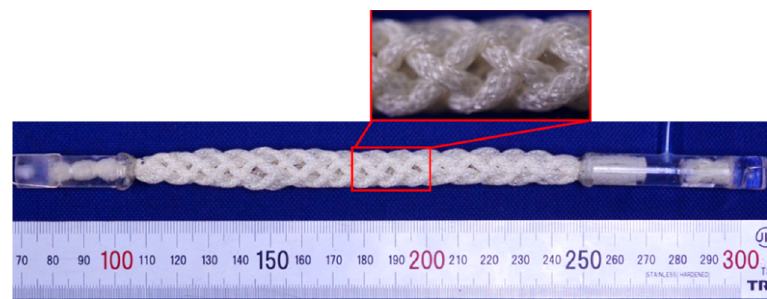
Figure 3. Active string actuator with air pressure of 0.3 MPa. Figure 2. Appearance and structure of the active string actuator. Figure 2. Appearance and structure of the active string actuator. Figure 2. Appearance and structure of the active string actuator.